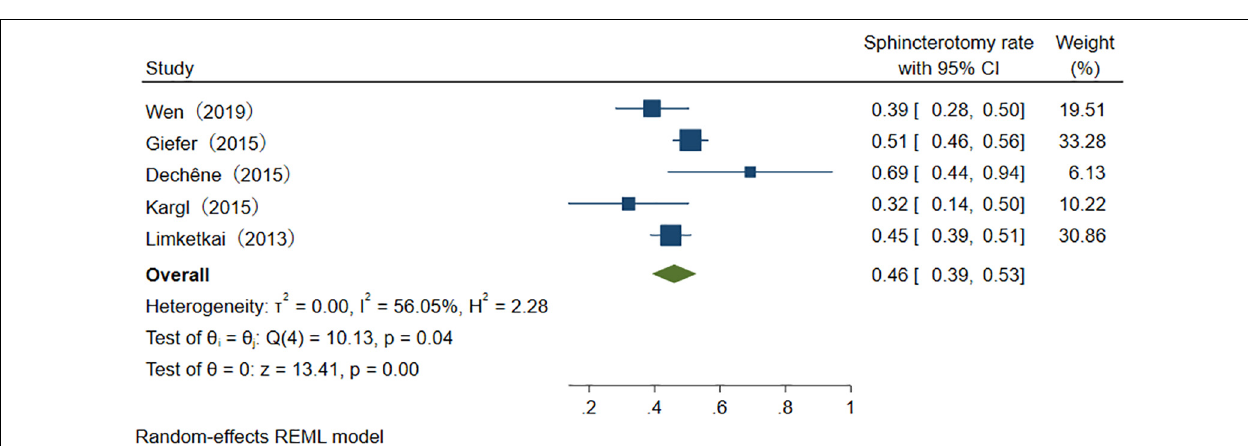
FIGURE 9 | The usage rate of stent placement.